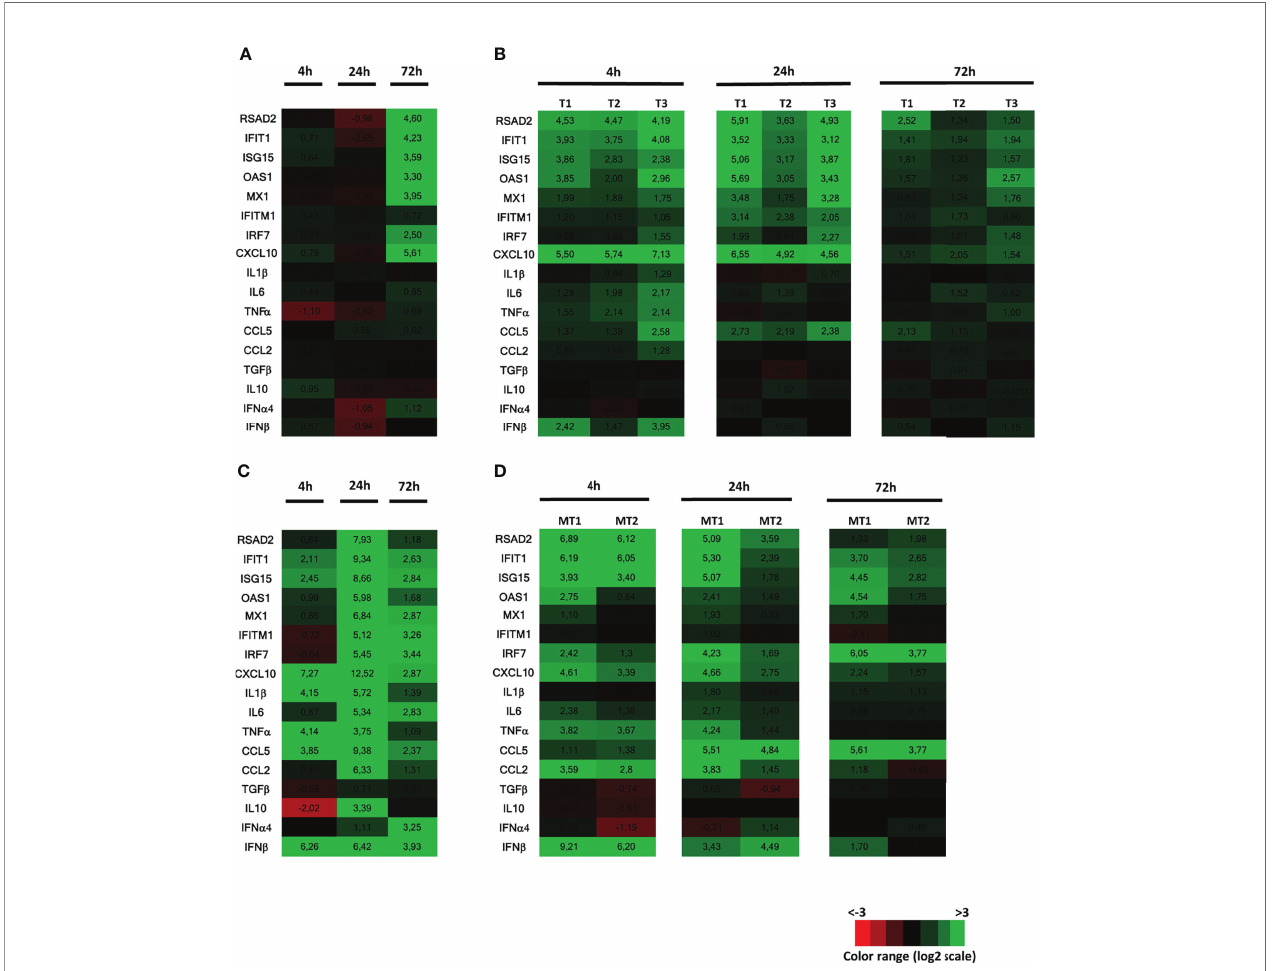
FIGURE 1 | Innate immune response of human testis to ZIKV infection or Poly(I:C) stimulation, compared with human placenta and mouse testis. Human testis explants were infected with ZIKV at TCI50 10 5 overnight (one donor representative of previously published data) (A) or stimulated with Poly(I:C) 25µg/mL (3 donors presented, representative of 8 donors) for 4h, 24h and 72h (B) . Human placenta explants (C) or mouse testis explants (D) were stimulated with Poly(I:C) 25µg/mL for 4h, 24h and 72h. Innate immune gene expression was determined by RTqPCR in the samples. Heatmap show log2-transformed expression ratios between infected or stimulated explants and time-matched mock-infected controls. Green indicates upregulation and red downregulation of mRNA compared with